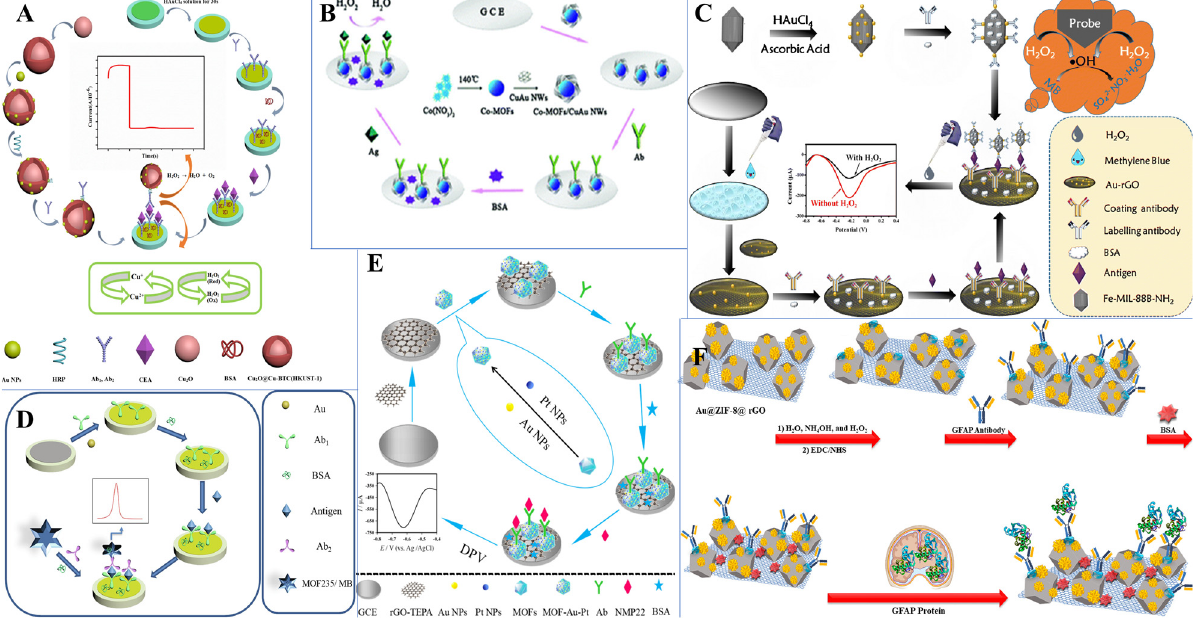
Figure 20. Schematic illustrations of ( A ) Fabrication of core-shell Cu 2 O@Cu-MOF@AuNPs-based electrochemical immunosensor for CEA detection. Reproduced with permission from Ref. [146] . Copyright 2020 Springer, ( B ) Preparation of Co-MOFs/CuAu NWs based label-free immunosensor for the detection of NMP-22. Reproduced with permission from Ref. [149] . Copyright 2019 Royal society of chemistry, ( C ) Fabrication of Au-MOF-based amperometric immunosensor for the detection of PSA. Reproduced with permission from Ref. [150] . Copyright 2020 Springer, ( D ) Preparation steps of AuNPs decorated MOF235/MB based electrochemical immunosensor for PSA detection. Reproduced with permission from Ref. [28] . Copyright 2021 Elsevier, ( E ) Stepwise assembly of AuNPs-PtNPs-MOFs based electrochemical immunosensor for the detection of NMP-22 in urine